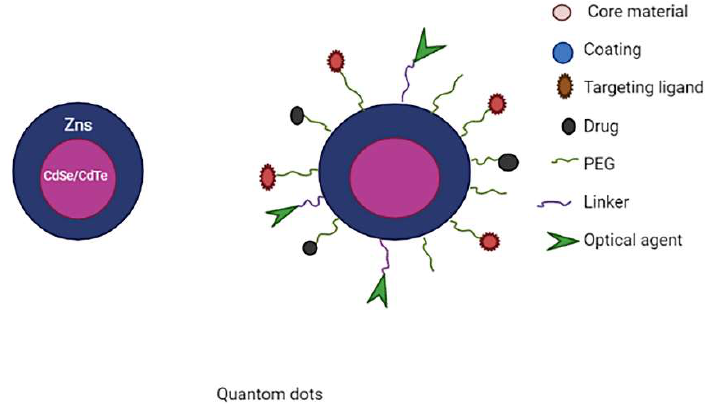
Figure 9. Schematic representation of multifunctional quantum dots.